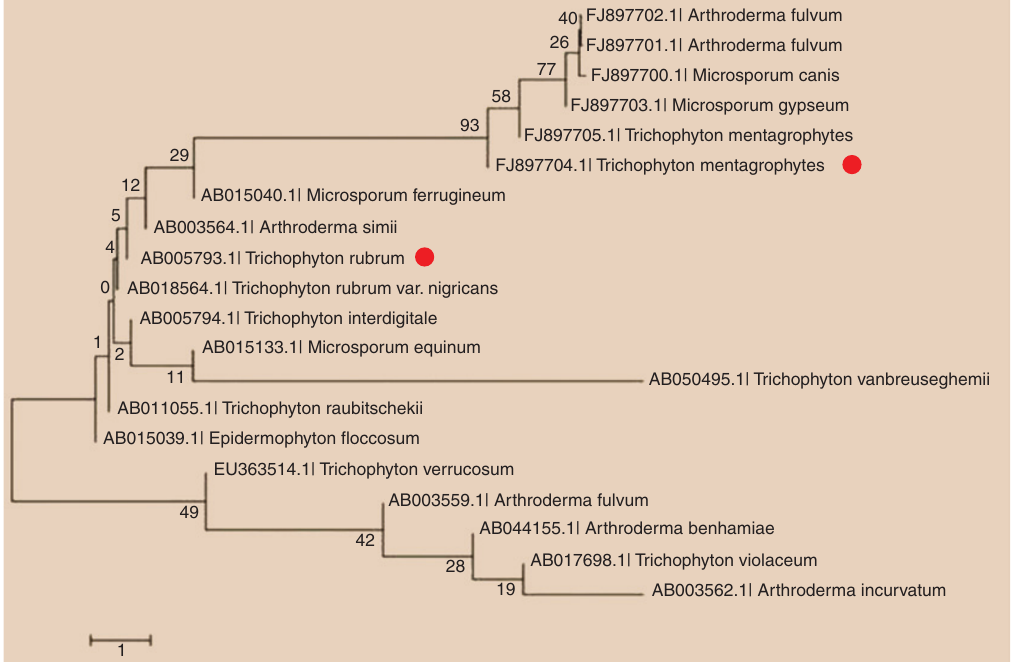
Figure 9: Molecular phylogenetic tree constructed using the sequences of chitin synthase gene 1 ( chs gene 1) of available strains of the some pathogenic fungi (ClustalW 1.6 alignment). The number of branch points represents the percentage of 1000 bootstrapped datasheets showing specific internal